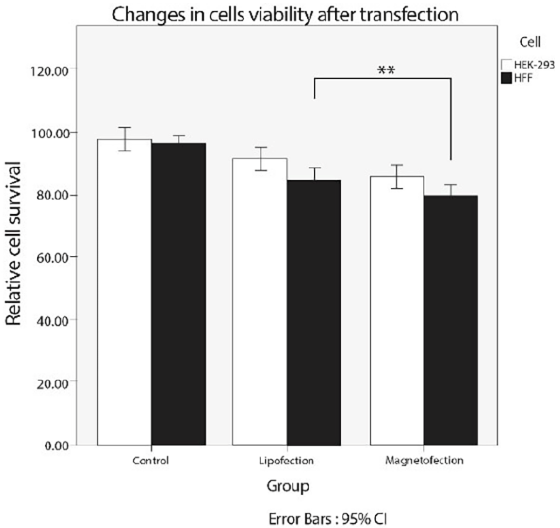
Figure 6. Assessment of cytotoxicity and cell viability using MTT assay 24 h post-incubation against CRISPR/Cas9-PEI-MNP complex-transfected HEK-293 and HFF cells using magnetofection and lipofectamine. The asterisks indicate a significant difference (** p < 0.01).